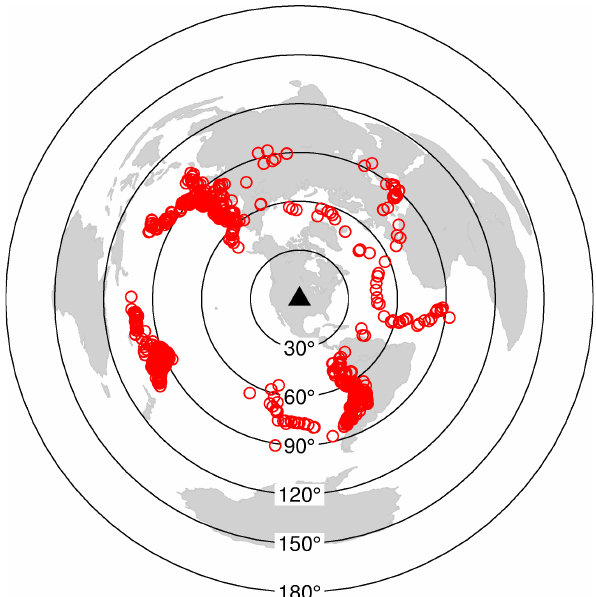
Figure 2. Epicenters of 1102 earthquakes used in our study. Black triangle marks the center of the network used. Black circles with labels indicate epicentral distances from the center. Not all earth- quakes have been recorded at all sites since the USArray stations were moved every 2